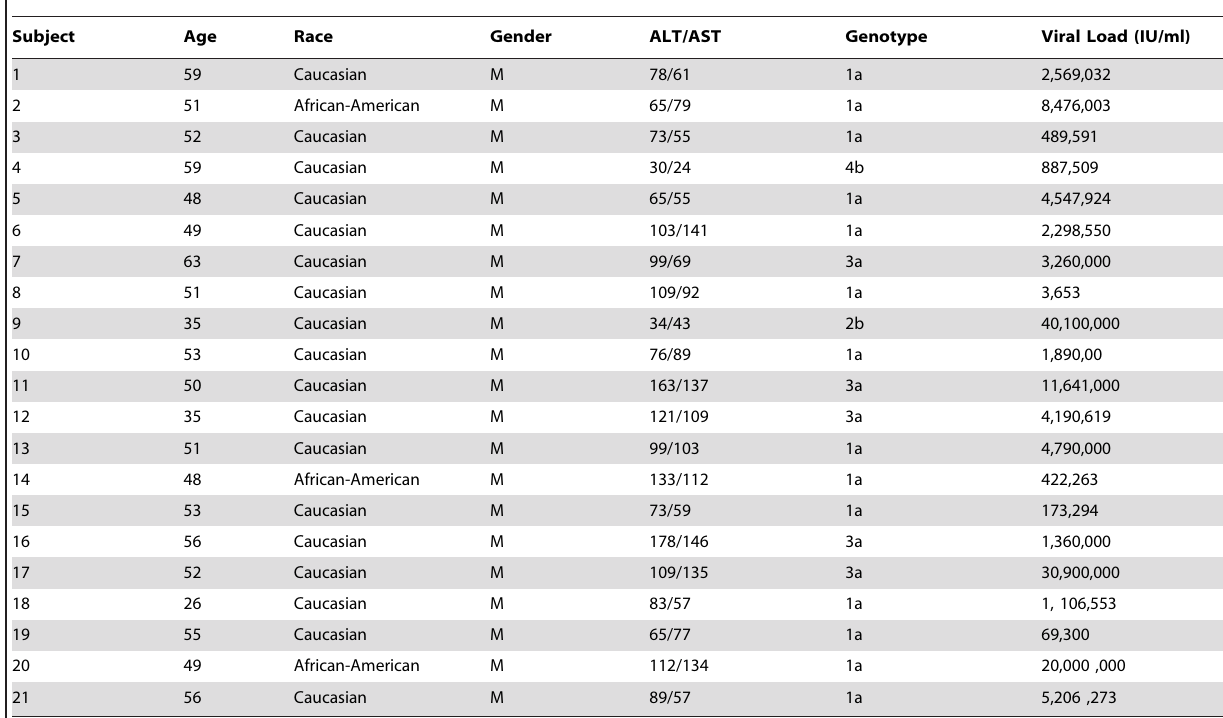
Table 1. Characteristics of subjects included in the